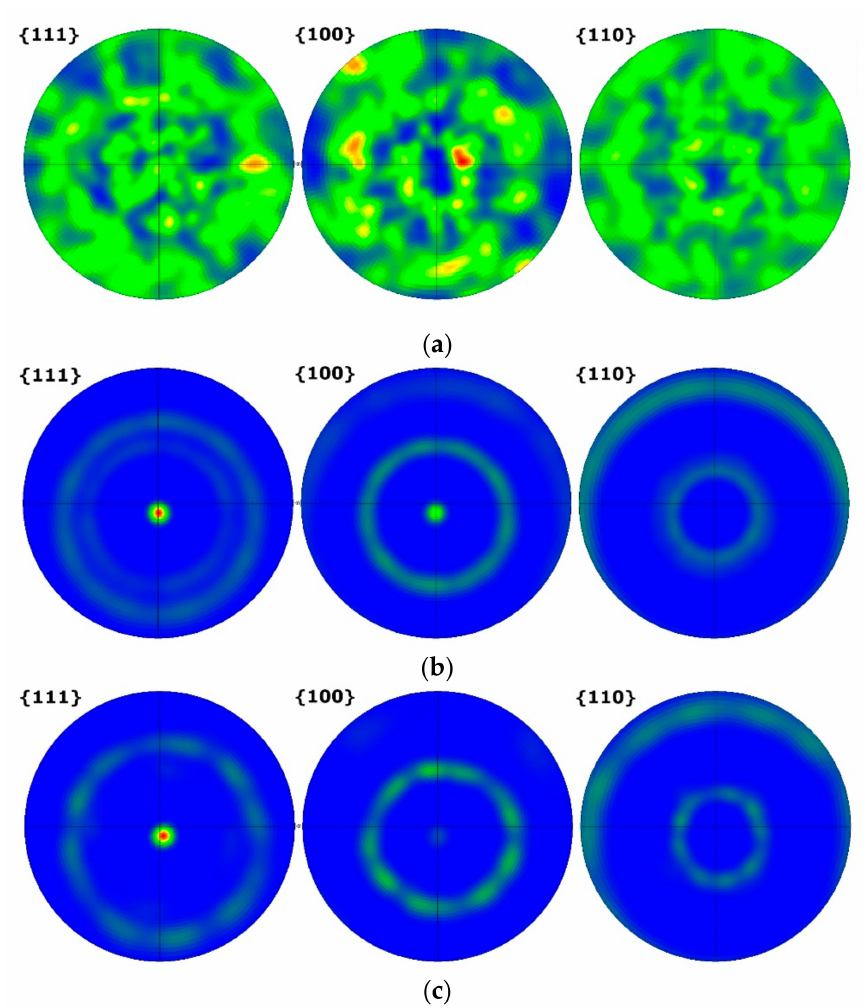
Figure 4. PFs of the: ( a ) CG T6, ( b ) HE10, and ( c ) HE8